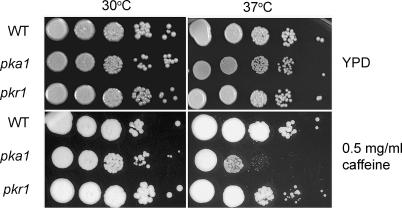
Sensitivity of PKA Mutants to CaffeineTen-fold serial dilutions of the WT and the pka1 and pkr1 mutants were grown on YPD medium containing caffeine at 30 °C and 37 °C. The strains used for all treatments are listed on the left side of the panel. The plates were incubated for 5 d before being photographed.